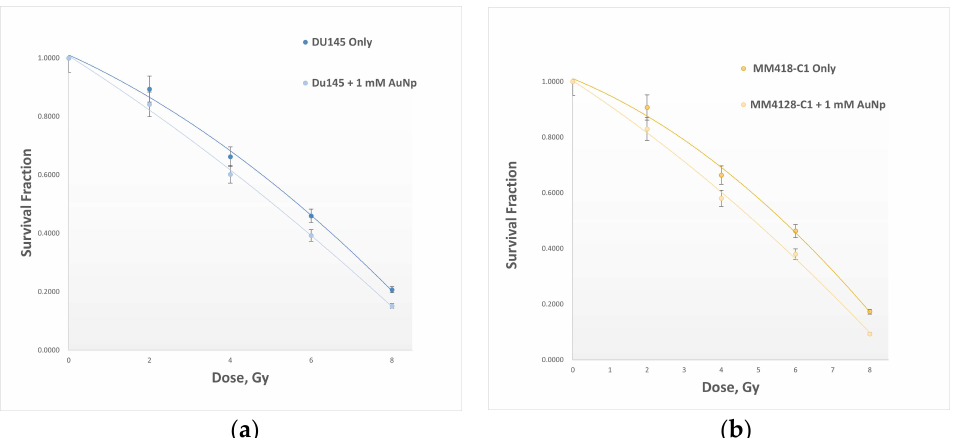
Figure 4. Cell survival curves quantifying the net 6-megavolt radiation dose enhancement caused by the impact of AuNPs on two cancer cell lines: ( a ) DU145, and ( b ) MM418-C1, both with and without AuNPs. Data are represented as mean values ± SD of three replicate samples.